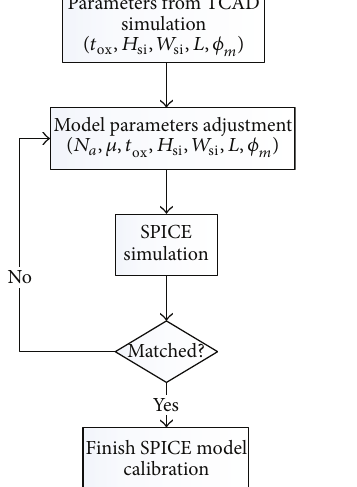
Figure 2: The calibration flow for model